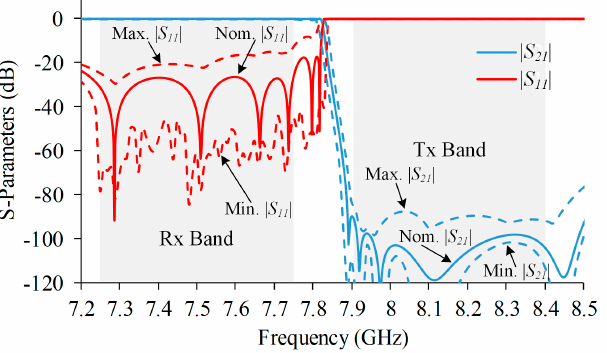
Figure 8. Simulated results of the designed Rx band filter with dimension from Table 1. Magnitude of S 11 is plotted with red color whereas magnitude of S 21 is plotted with blue color. Solid lines correspond to nominal values and dashed lines limit the maximum and minimum values obtained after